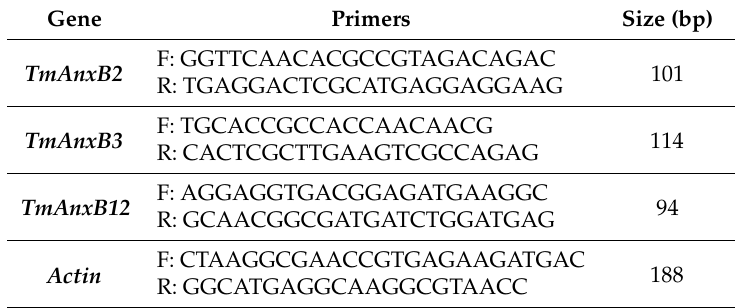
Table 2. Primers used for quantitative real-time PCR (qRT-PCR) amplification of T. multiceps annexins.